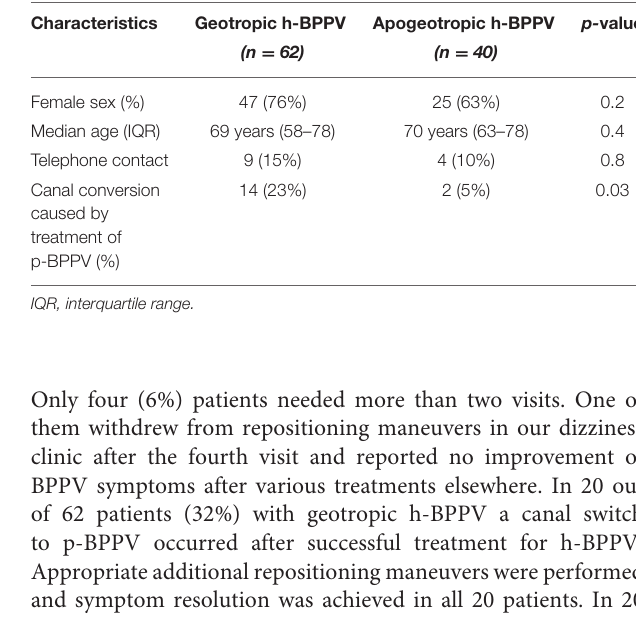
TABLE 1 | Baseline characteristics of patients with geotropic h-BPPV and apogeotropic